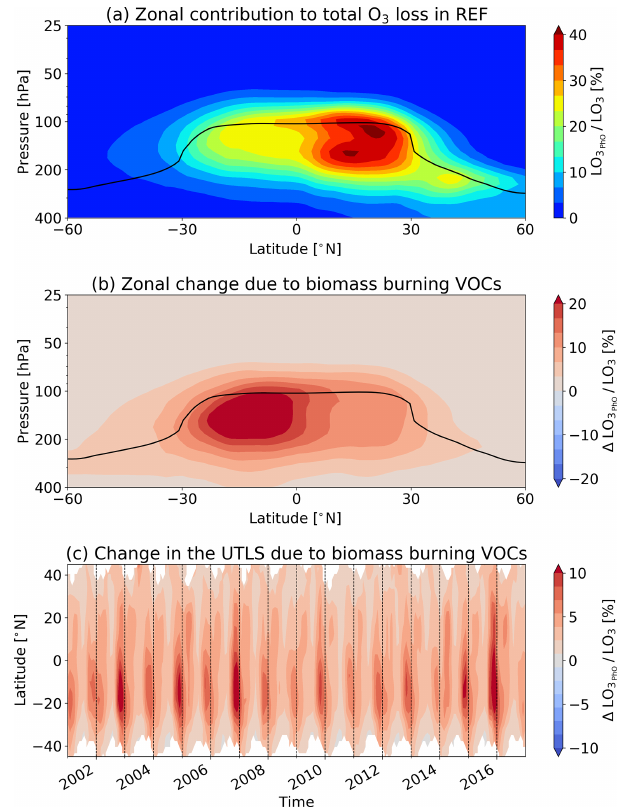
Figure 13. Zonal mean contribution of the destruction of O 3 by phe- noxy radicals (Reaction R2) to the total chemical O 3 loss. (a) Rel- ative contribution if no VOC biomass burning emissions are taken into account (REF) in November 2015. (b) Changes in the rela- tive contribution due to VOC biomass burning emissions (FIR) in November 2015. (c) Changes in the relative contribution due to VOC biomass burning emissions in the UTLS. Here, we define the UTLS from 250 to 50hPa above the tropopause calculated by EMAC. The tropopause pressure level in panels (a) and (b) is indi- cated in black.